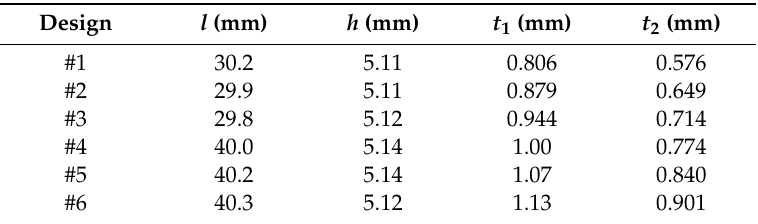
Figure 1. Three-dimensional (3D) printed nylon cantilever diagrams. ( a ) The defined dimensional variables. ( b ) System diagram of the experimental setup used for cantilever resonant frequency analysis. Table 1. Dimensional Measurements: 3D Printed Nylon